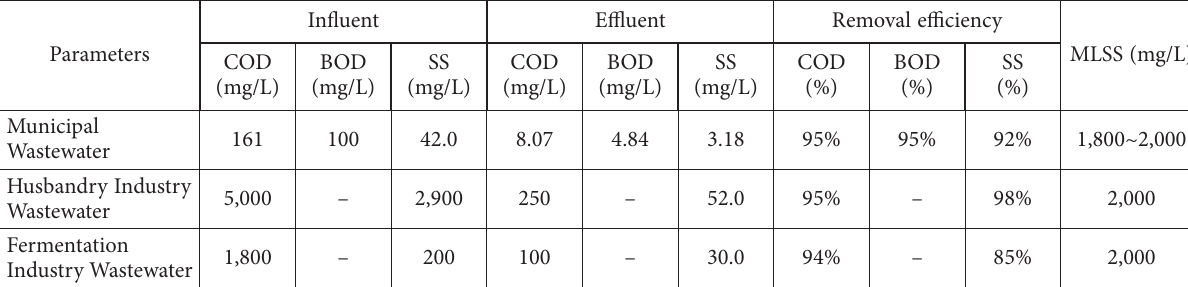
Table 1. Water quality of the wastewater treatment plants corresponding to the different waste sludge sources